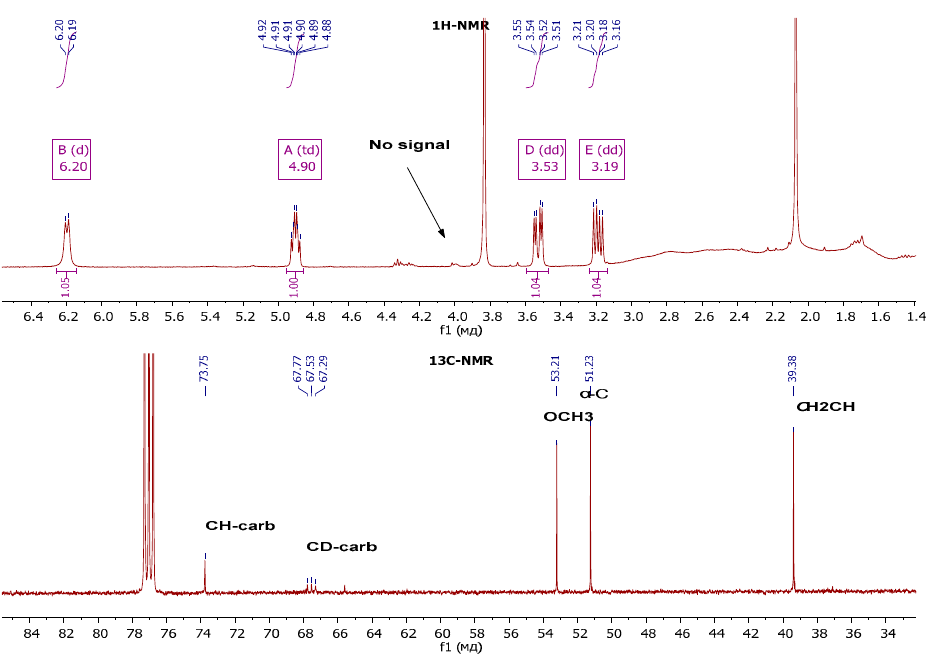
Figure 8. 1 H and a fragment of 13 C NMR spectra of 12 in CDCl 3 .